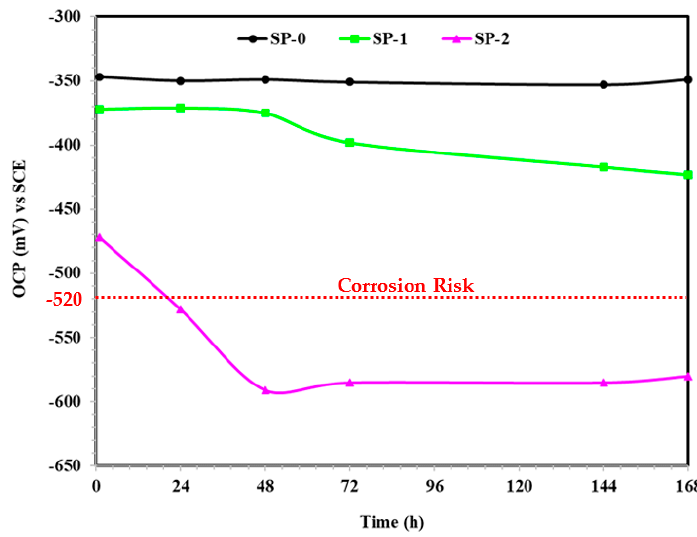
Figure 1. OCP measurement with immersion time.